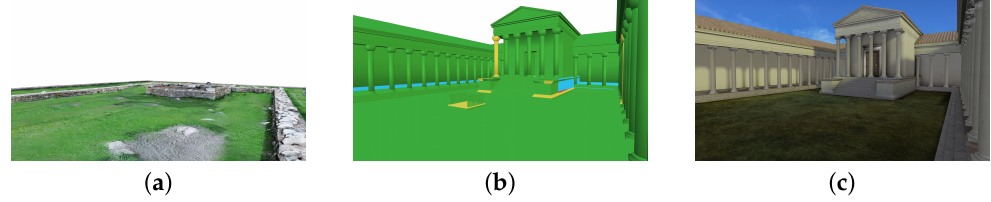
Figure 10. Digital Replica (DR, a ), Proxy model ( b ) and Representation Model (RM, c ) of the Great Temple. See colour chart in Table